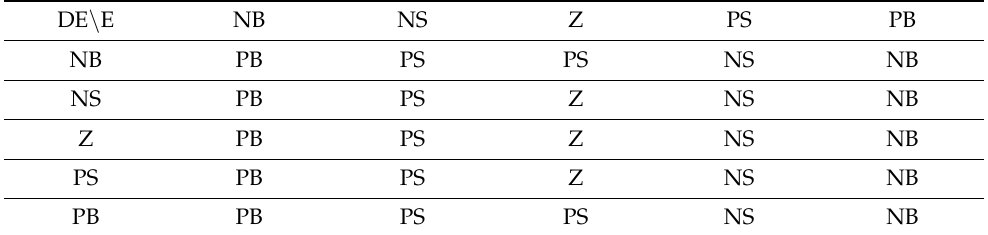
Table 2. Rules of the fuzzy controller.